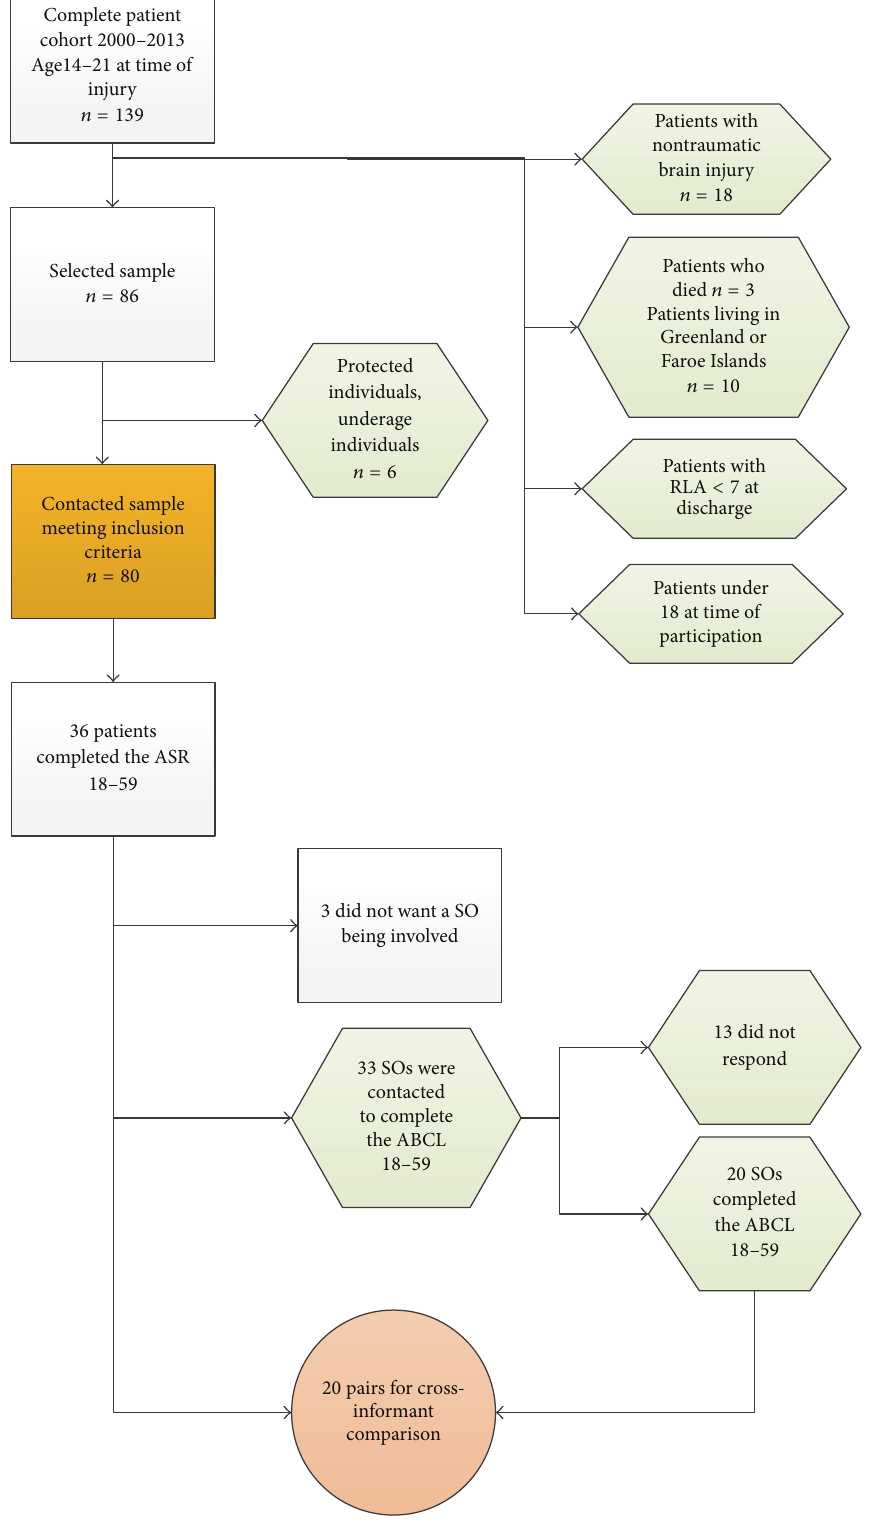
Figure 1: Flowchart of participant